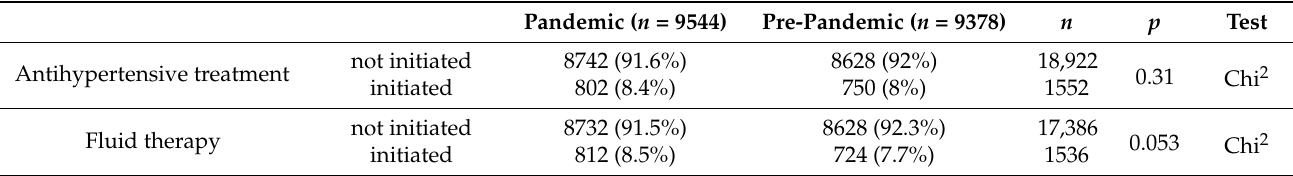
Table 4. Types of pharmaceuticals used.